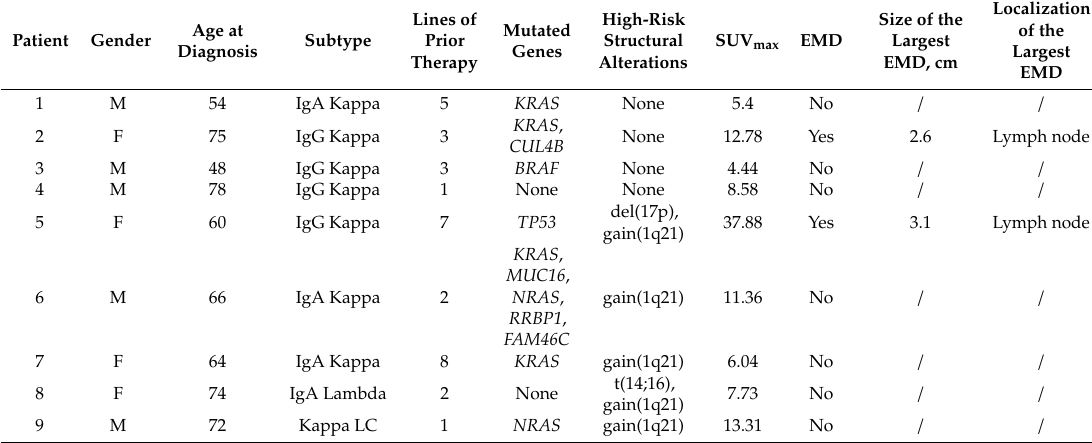
Table 3. Whole-genome sequencing and imaging patterns in 18F-FDG PET / CT scans. High-Risk Lines of Mutated Age at Structural Subtype Prior Patient Gender Genes Diagnosis Therapy